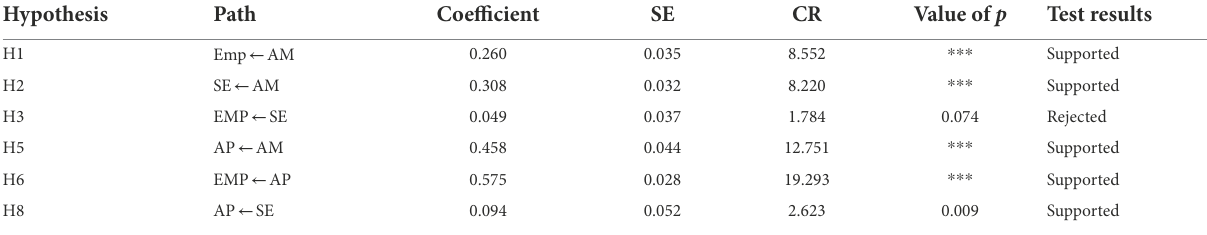
TABLE 5 Test results of the proposed hypothesis.